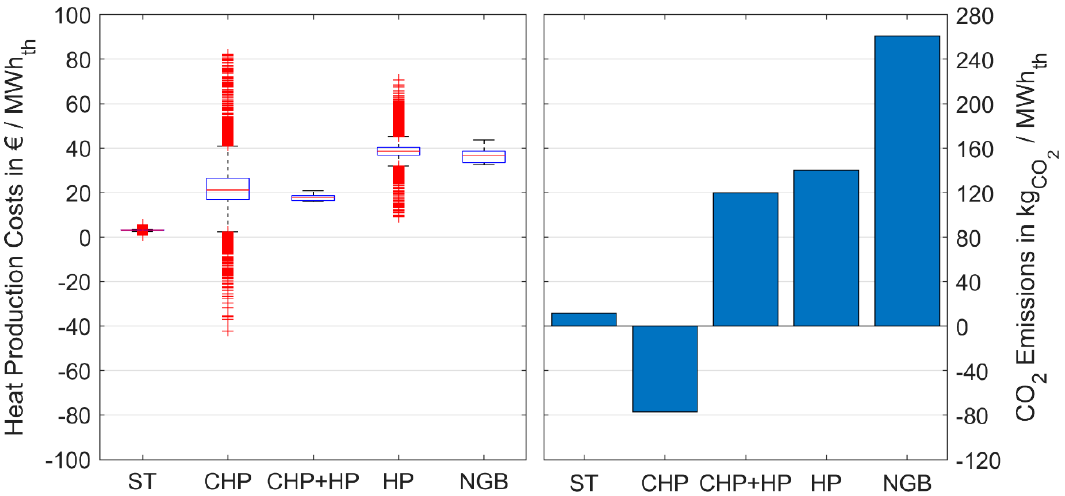
Figure 13. Scenario 2—Distribution of the real heat production costs and values of CO 2 emission factors for different heat generators for the energy policy framework conditions in Germany based on data from 2017 and 2018, without KWKG but with electricity credit method